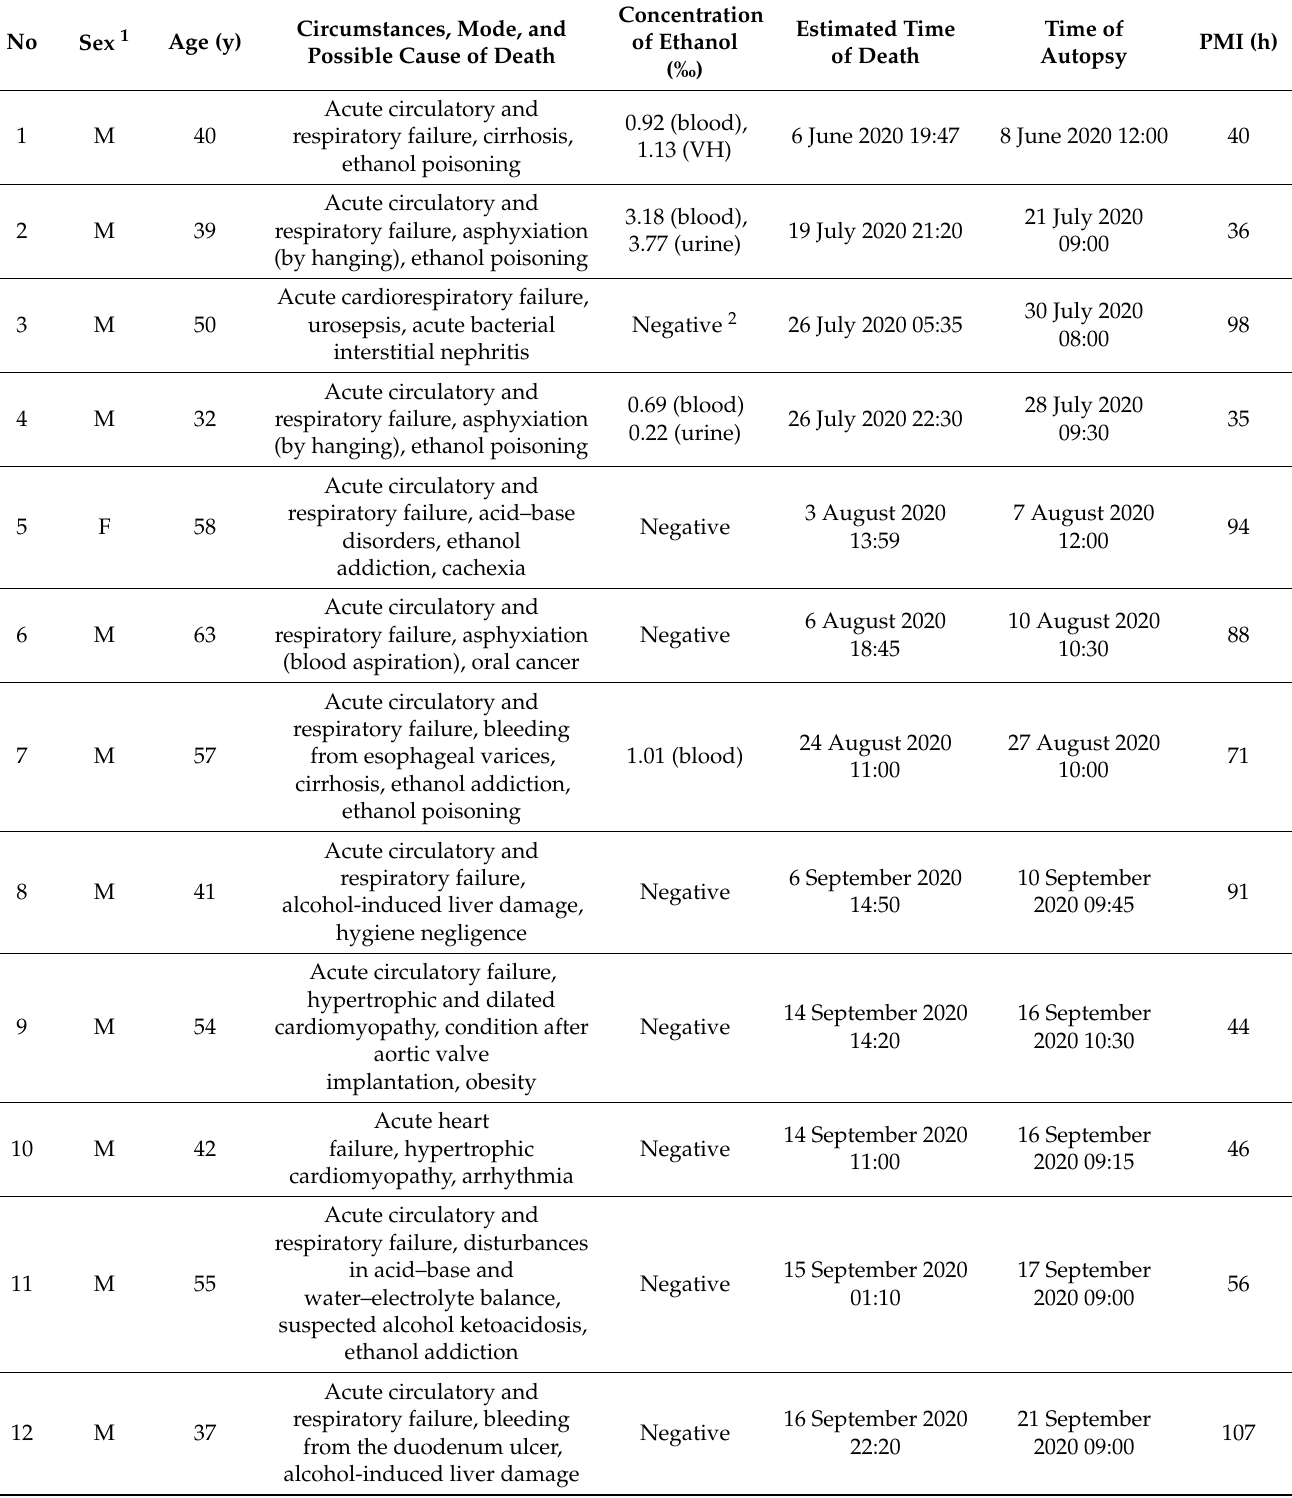
Table 3 summarizes the data of the deceased: gender, age of death, blood alcohol content and other biological materials, cause of death, TOD or disclosure of the body, and time of postmortem examination. Table 3. Selected data of the deceased individuals autopsied in